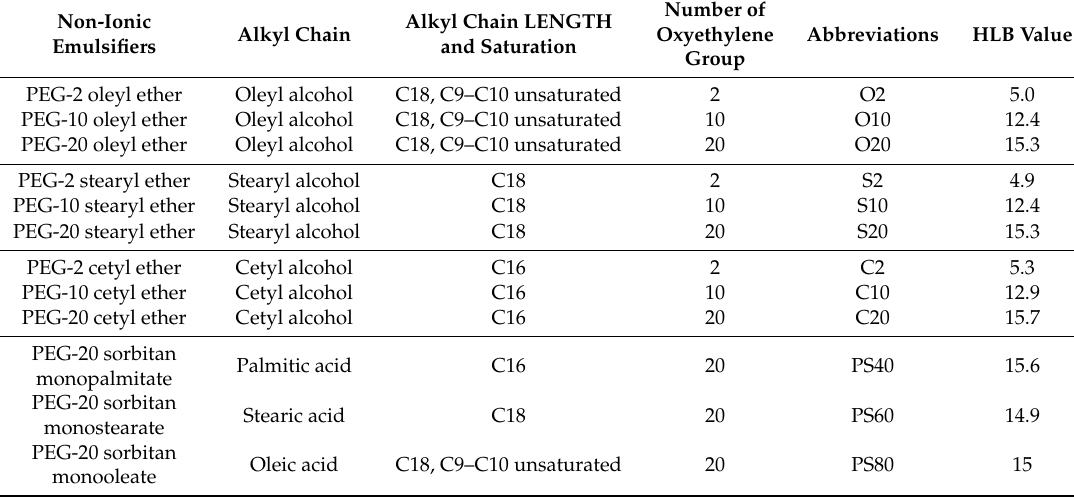
Table 1. Characteristics of non-ionic emulsifiers including polyethylene glycol (PEG) alkyl ethers and PEG sorbitan esters used in this